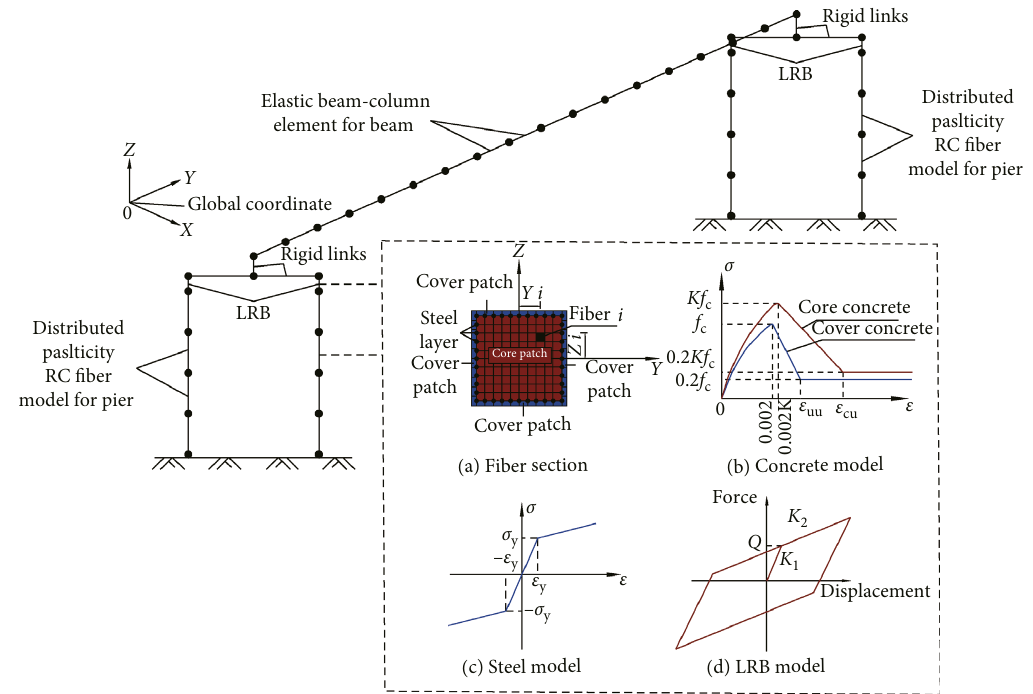
Figure 3: Nonlinear analytical model with models of materials and isolation